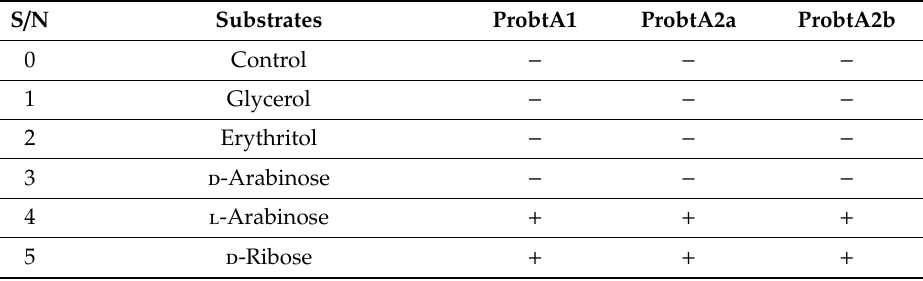
Table 3. The sugar metabolism pattern of the isolated lactic acid bacteria